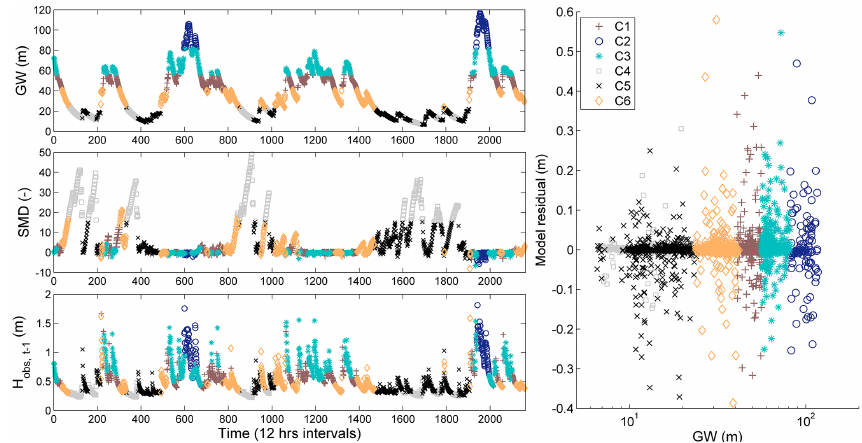
Figure 5. Fuzzy clustering of GW (left, top) and its relation to the model residuals (right), SMD (left, middle) and H obs , t − 1 (left, bottom) for the calibration period (7 March 2007, 08:00UTC–7 March 2010, 08:00UTC) – Llanyblodwel, lead time 6h.